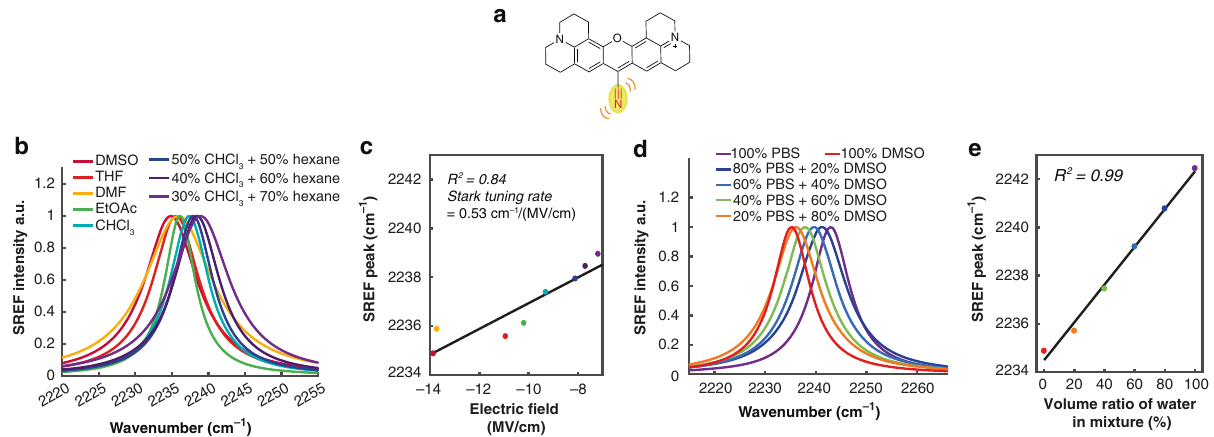
Fig. 2 Spectroscopic characterization of vibrational sensing effect of SREF with Rh800. a SERF sensing with the nitrile mode of Rh800. b SREF spectra of C ≡ N band of Rh800 ( (cid:1) ν ) dissolved in different aprotic solvents and mixtures. c (cid:1) ν C (cid:4) N the Onsager reaction fi eld theory. d SREF spectra of nitrile in different DMSO – water mixtures. e Plot of (cid:1) ν